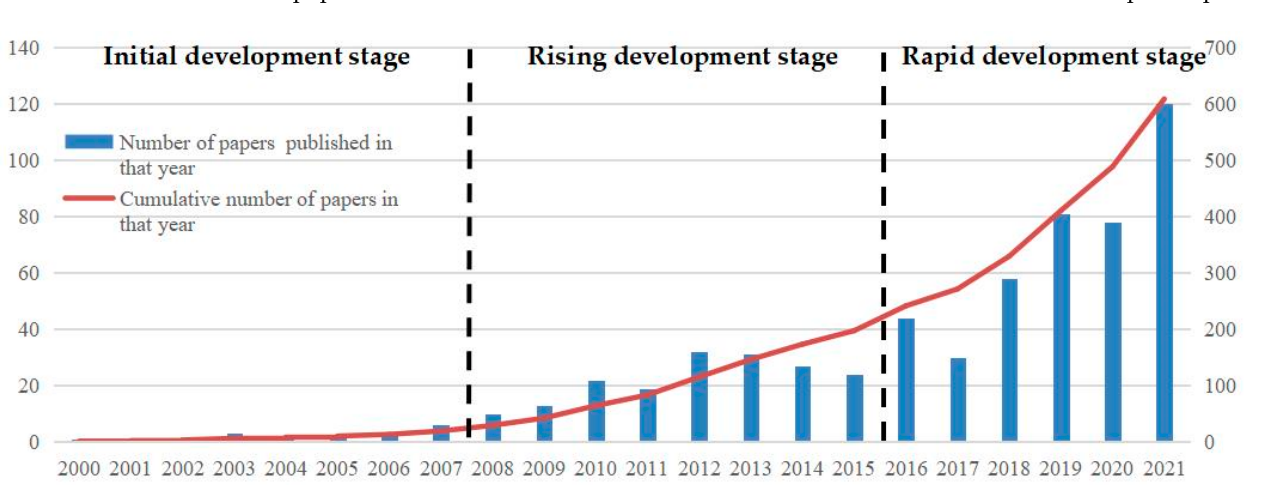
tional research